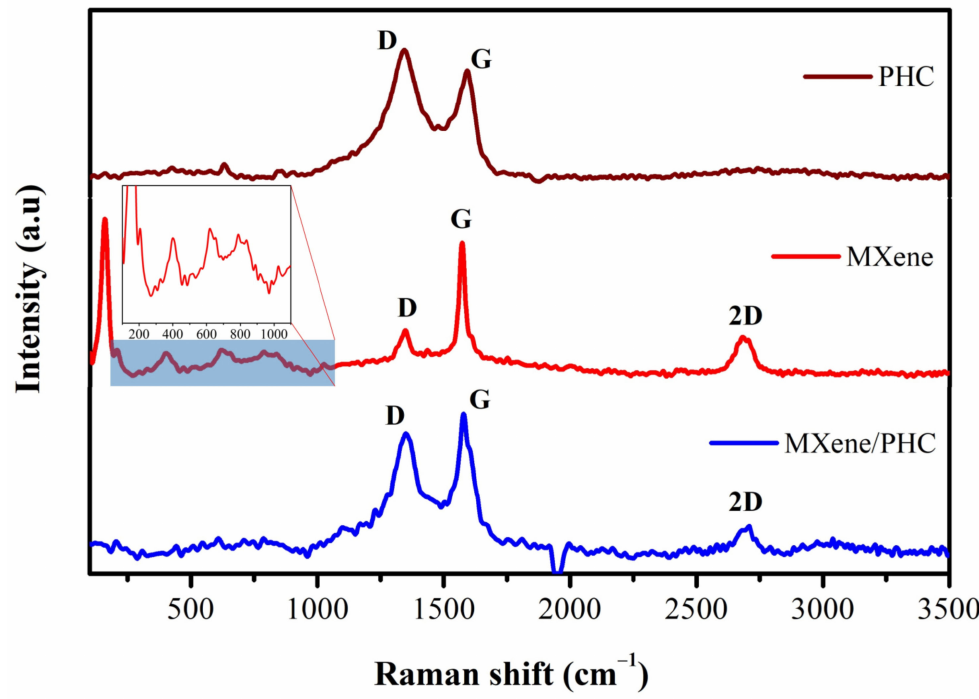
Figure 2. Raman spectra of PHC, MXene and MXene/PHC composite. Inset: an enlarged spectrum of